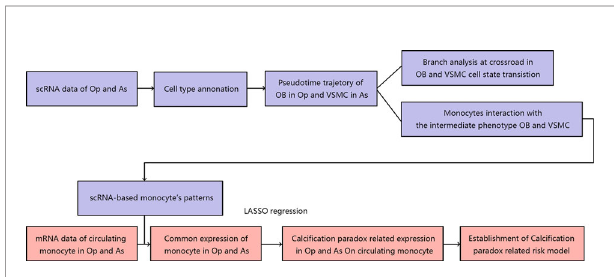
FIGURE 1 | Design of the experiment and work fl ow of this